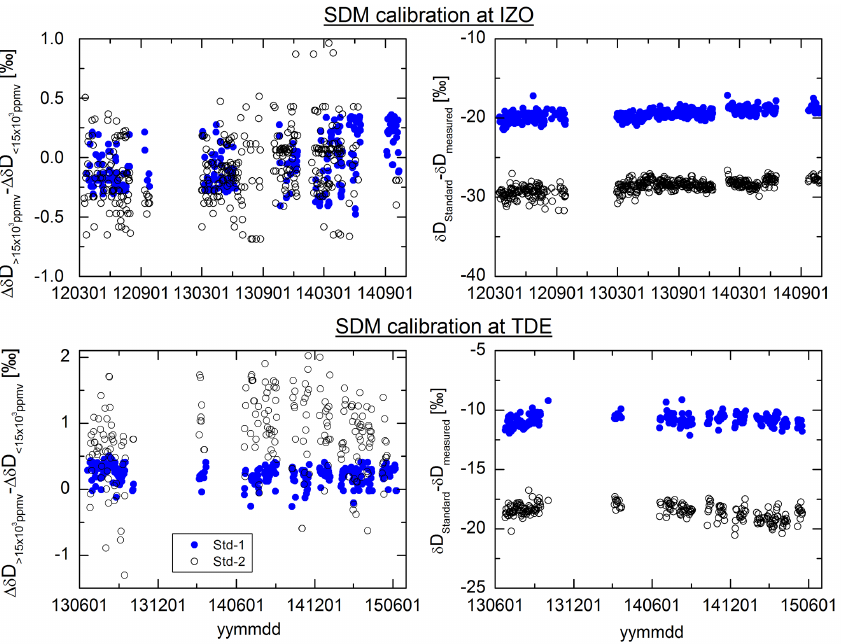
Figure A2. Difference between the measured δ D and that from the two liquid standards used for calibrating the instruments at IZO (first row) and TDE stations (second row). The left column depicts the dependence of this difference to the humidity during calibration. The right column shows the evolution of the difference with the time for all humidity levels.